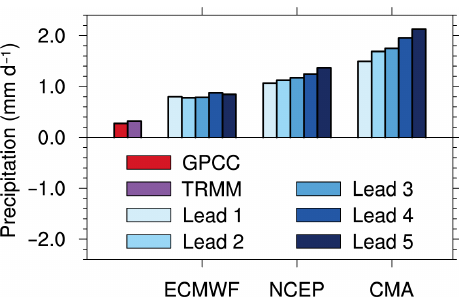
Figure 6. The multiyear wintertime mean precipitation over the Ti- betan Plateau (unit: mmd − 1 ) for the observations and forecasts in each